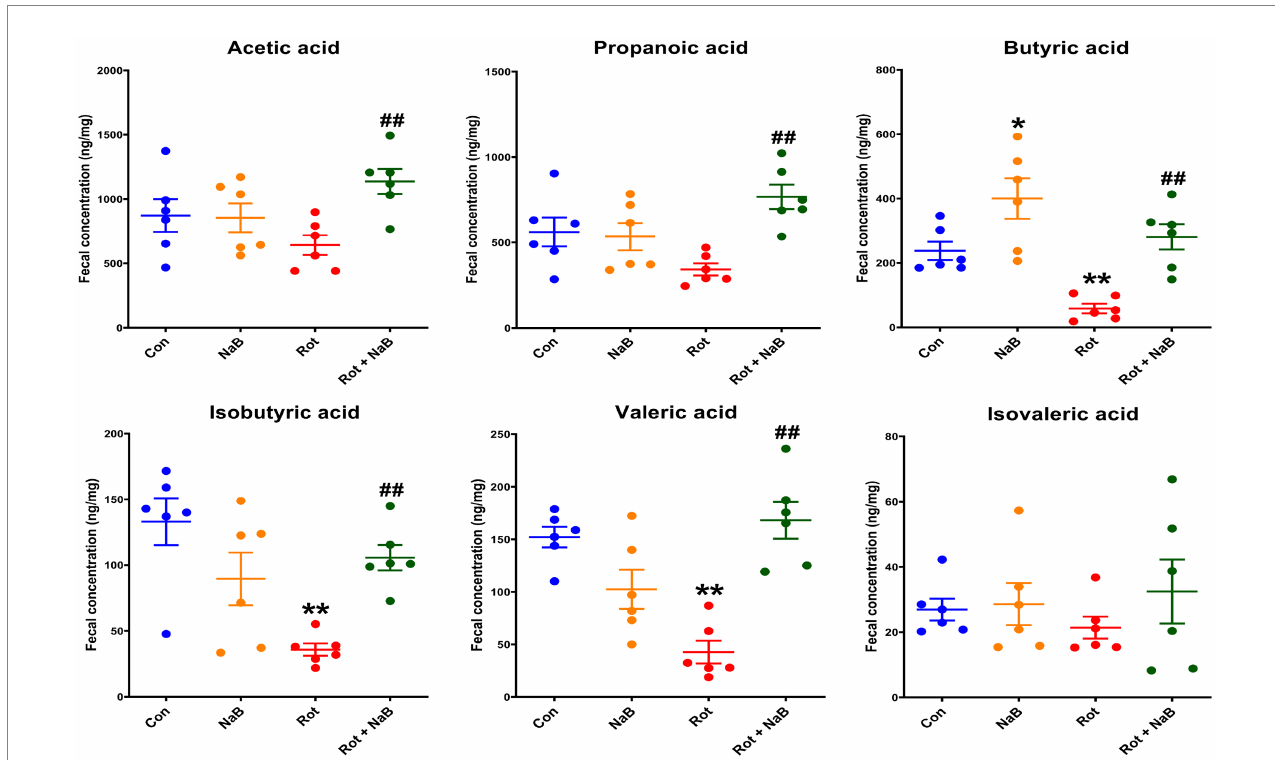
FIGURE 6 NaB improves rotenone-induced fecal SCFAs metabolism disturbance. Bar plots of the fecal acetate, propionate, butyric acid, isobutyric acid, valeric acid, and isovaleric acid levels. n = 6 per group. The data represent the mean ± SEM. * p < 0.05, ** p < 0.01 vs. Con group; ## p < 0.01 vs. Rot group. Con: control; NaB: sodium butyrate; Rot: rotenone; SCFAs: short chain fatty acids.